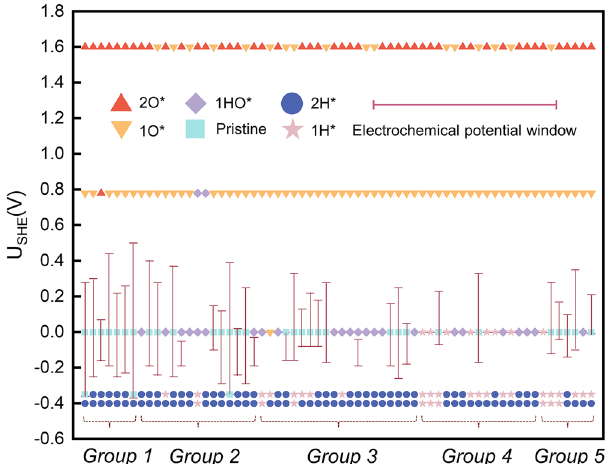
Fig. 5 Surface states of Fe-Ni-N x -C at the common potentials of HER (0 V), OER (1.60 V), ORR (0.78 V), CO 2 RR ( − 0.35 V), and NRR ( − 0.4 V). Groups 1 – 5, respectively, indicate the number of coordinating N: 0 – 1, 2, 3, 4, and 5 – 6. The pink vertical lines represent the electrochemical potential window (EPW) of DACs and various symbols fi lled with different colors represent different occupying species. In detail, we employed the red upper triangle, orange lower triangle, purple diamond, cyan square, indigo circle, and pink star to describe DACs will be covered by 2O*, 1O*, 1OH*, pristine, 2H*, and 1H*, respectively, at the operating potentials.